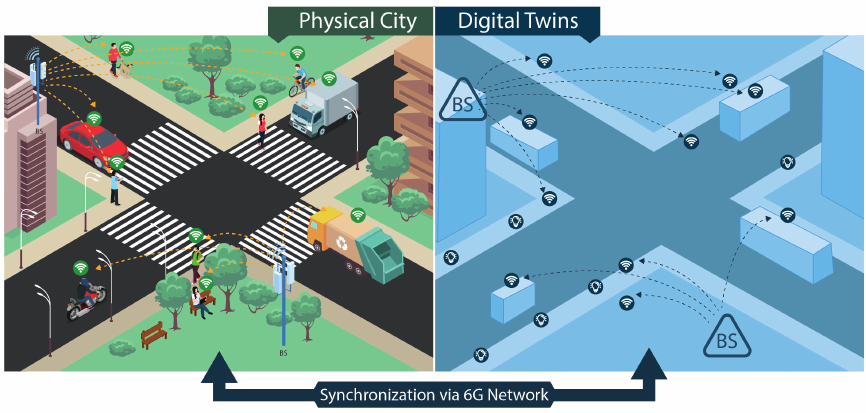
Figure 5. Large Scale Digital Twins use case: Physical city and its corresponding digital